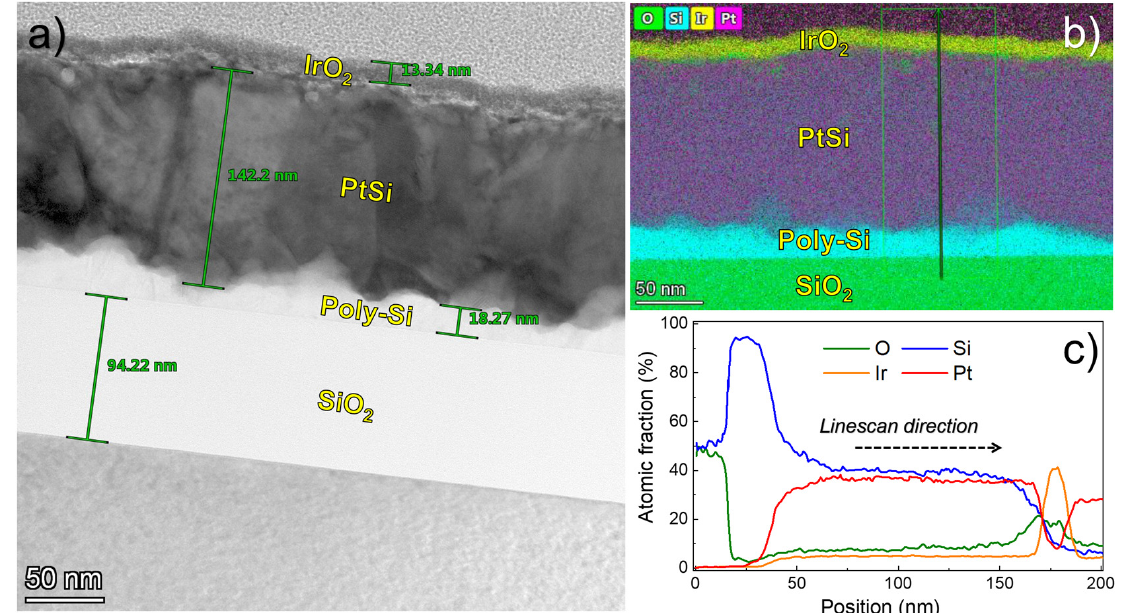
Figure 4. ( a ) TEM cross-section image of IrO 2 on PtSi. ( b ) EDS mapping of IrO 2 on PtSi. ( c ) Linescan composition map of IrO 2 on PtSi. The analysis reveals a continuous and conformal IrO 2 layer on PtSi. The Pt detected by EDS on the surface is due to the deposition of Pt as an electronic contrast layer during the specimen preparation.